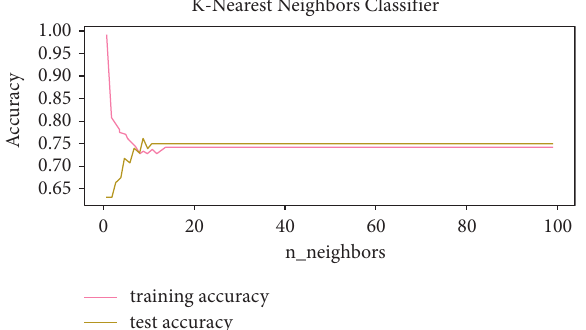
Figure 6: K-NN computation for training and test datasets.